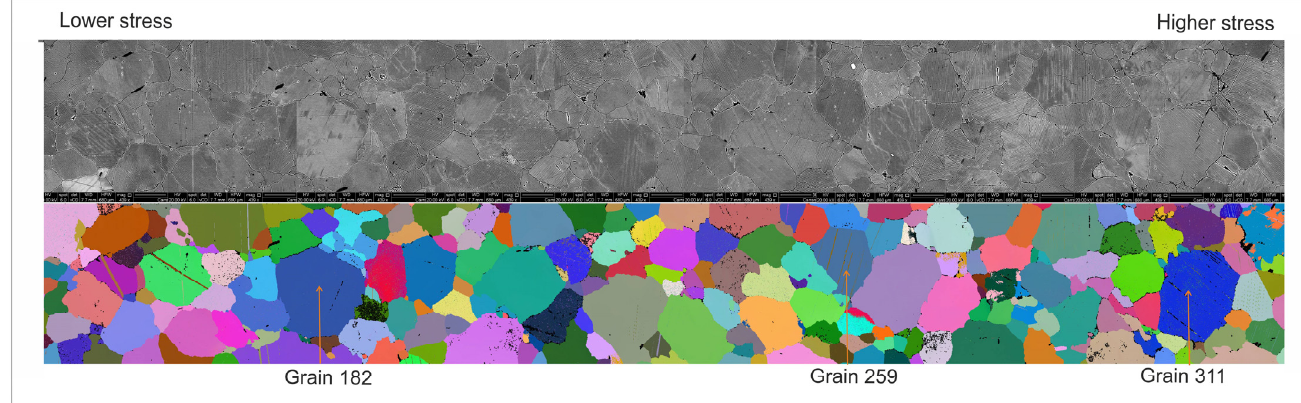
Figure 5. Example of grains sampled for EBSD analysis in the central region of the sample. The upper image shows electron channelling contrast. Traces of twin lamellae can be seen inside most grains and there is no evidence of significant microcracking nor grain boundary dilatation. The lower image is an Euler angle image, in which red-green-blue values are assigned based on the magnitude of each Euler angle. Three grains have been labelled by their number identifiers, by way of illustration. Most of the grains do not show twin lamellae visible in the Euler image, because most twins are too thin to be measured by the incident electron beam. The length of the portion of the section shown is 4.61 mm.